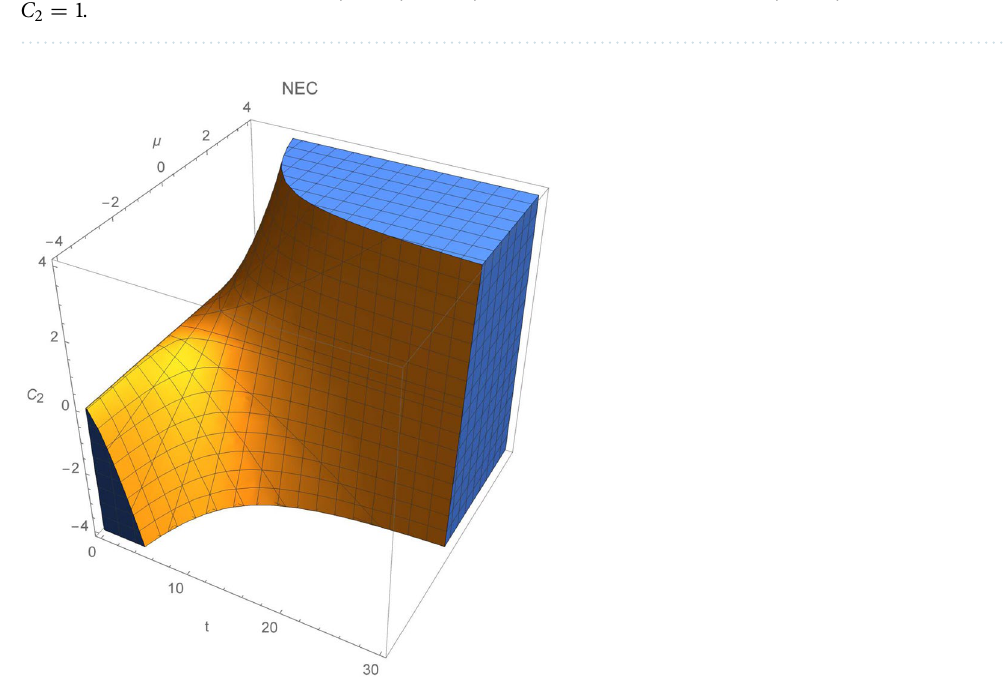
Figure 11. Region where NEC (and WEC) is